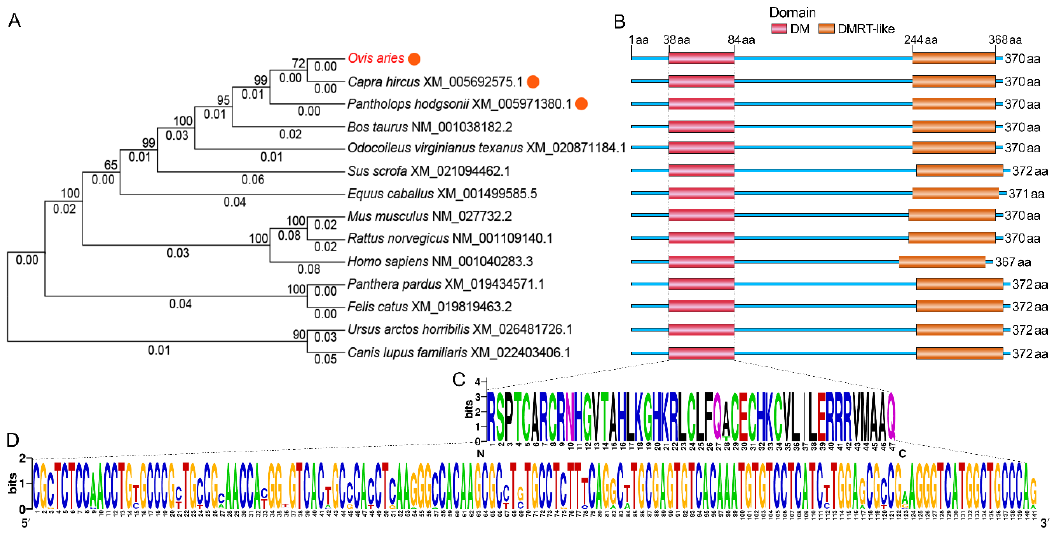
Figure 5. Temporal expression patterns of DMRTC2 mRNA in developmental testes and epididymides. Data show means ± SD from eight independent experiments. **: p < 0.01, *: p < 0.05, and ns (no significance): p > 0.05. 3 M: three months old, 1 Y: one year old, and 3 Y: three years old.